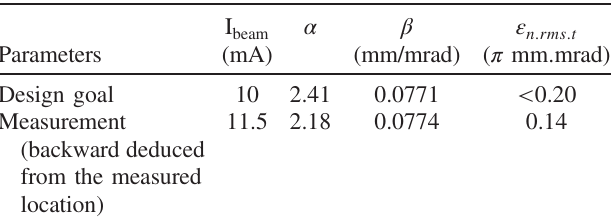
TABLE I. The measurements versus the design goal of the beam current, Twiss parameters and normalized RMS emittance at the exit of the LEBT.